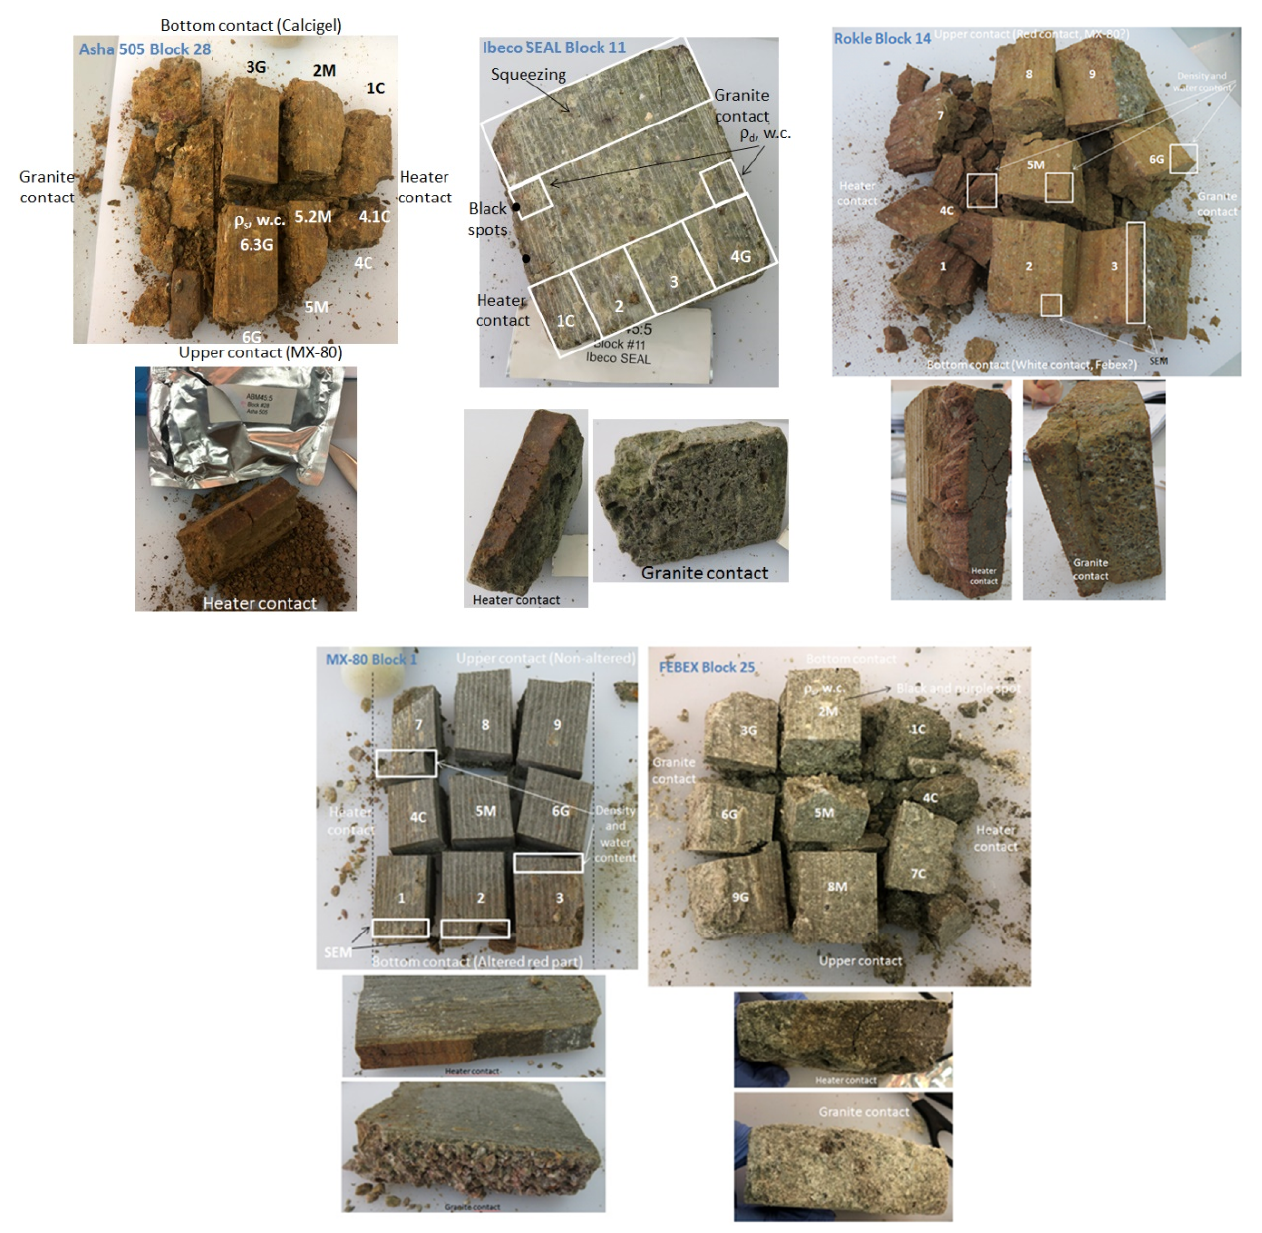
Figure 3. Sampling of the bentonites at laboratory for performing different analyses.